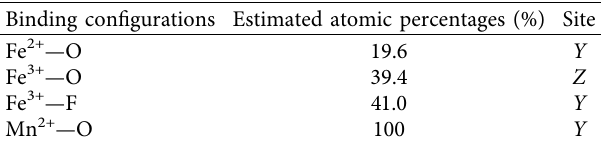
Figure 6: High-resolution XPS survey of Fe2p and Mn2p: (a) Fe2p and (b) Mn2p. Table 1: Different binding configurations, estimated atomic per- centages, and occupancy sites of Fe and